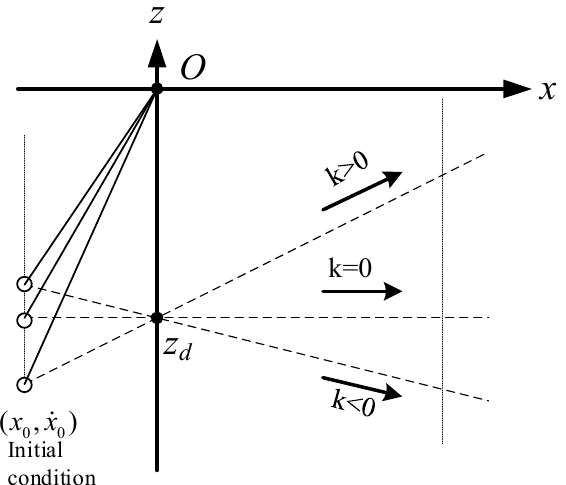
Figure 7. Motion of LPM in X-direction is independent of the slope of the constraint line.